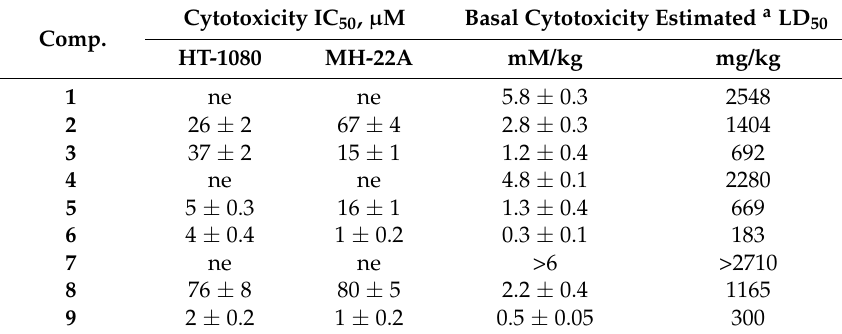
Table 1. Comparison of cytotoxicity, estimated basal cytotoxicity of 4-( N -alkylpyridinium)-1,4-DHP derivatives 1 – 9 .